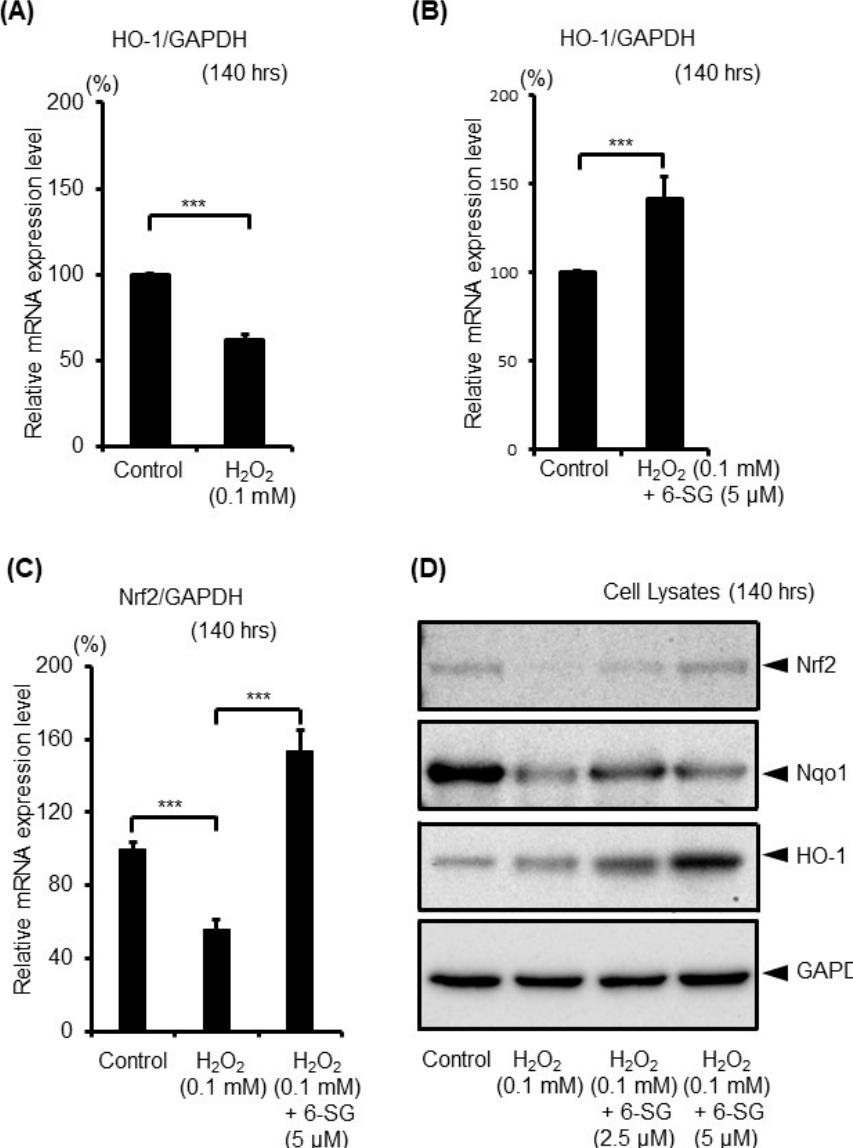
Figure 4. Expression level of endogenous anti-oxidant response genes in cultured human epidermal melanocytes after exposure to the indicated treatments with 6-SG for 140 h. ( A , B , C ) mRNA expression analyses using real-time PCR; ( D ) Protein expression analyses using Western blot. Data in ( A ), ( B ) and ( C ) represent the results of three independent experiments. Data in ( A ), ( B ) and ( C ) are shown as mean ± SD, normalized to GAPDH. n.s., no significant difference; ***, p < 0.01. Representative Western blot (of three independent experiments performed) are shown, GAPDH was used as a loading control. 2.5. 6-SG Protects Melanocytes Against Rhododendrol-Induced Oxidative Stress Rhododendrol [4-(4-hydroxyphenyl)-2-butanol, Rhododenol ® ] was previously used as a skin- whitening cosmetic. These cosmetics were withdrawn from the market in 2013 after Rhododendrol reportedly caused a depigmentation disorder [31]. A previous report suggested that the toxicity of Rhododendrol towards melanocytes is caused by its tyrosinase-catalyzed oxidation and the production of cytotoxic reactive oxygen species (ROS) [32–34]. In the present study, we investigated